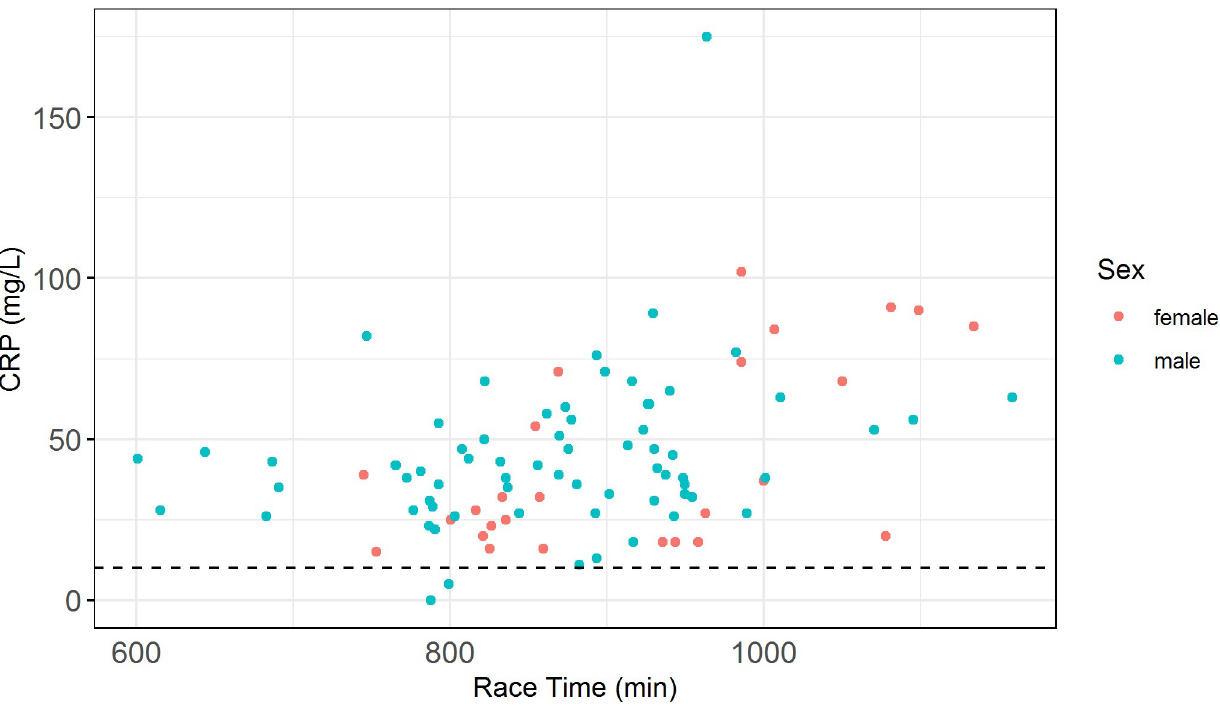
Fig 3. Individual CRP values the day after the Norseman in relation to race